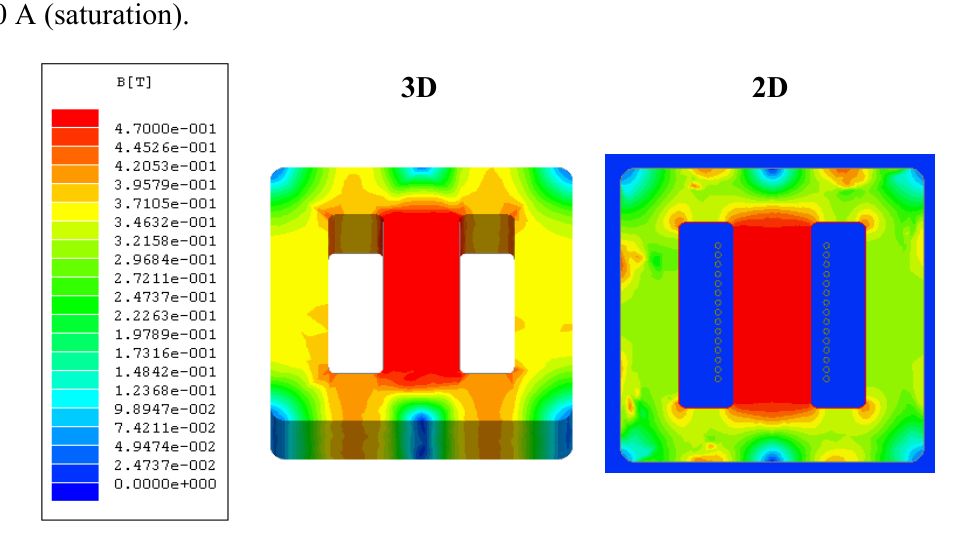
Figure 8. Results for g = 0 µm. Distributions of the | B | and | H | fields along the x -axis computed by 2D (—) and 3D (—) simulations, for ( a , b ) I = 0.01 A (linear region) ( c , d ) I = 10 A